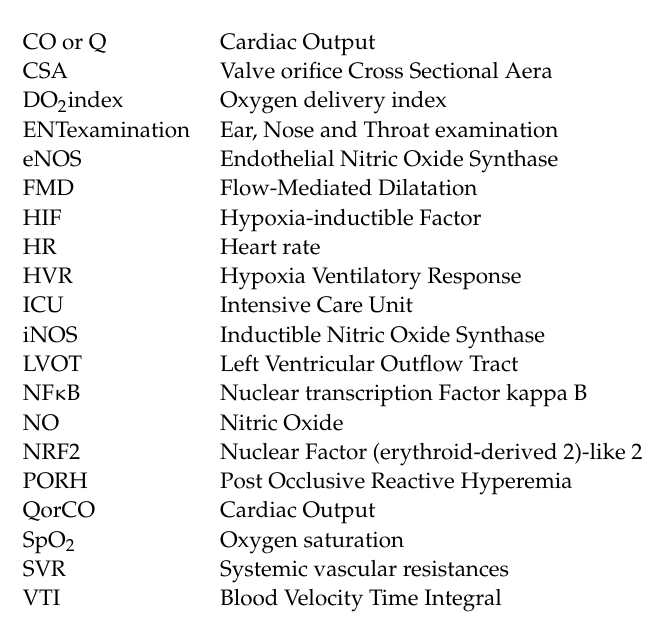
Figure 2. Our thoughts are also with David de Bels (co-author) who passed away during the revision of this